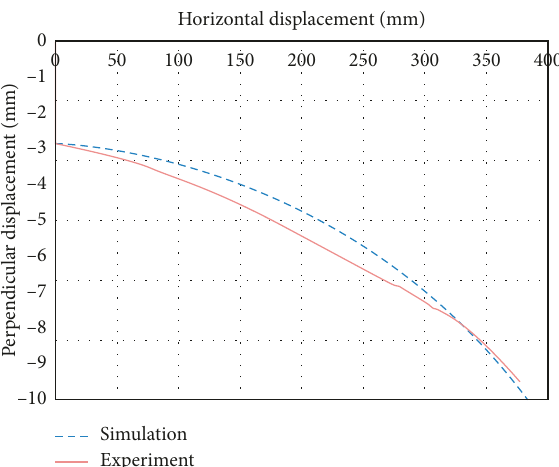
Figure 31: Comparison of vertical displacement-horizontal dis- placement relationship curve.